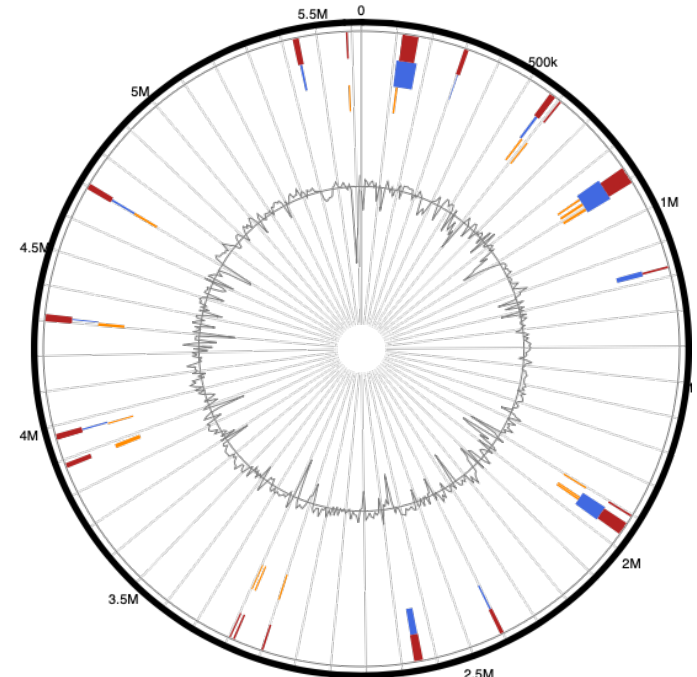
Figure 3. Circular map of the Pseudomonas putida TT321 genome. Genome islands (GIs) are highlighted by color within the circular map for prediction methods. Orange and blue were predicted by SIGI-HMM and IslandPath-DIMOB, respectively. Red regions were predicted GIs by at least one method (integrated GIs). GC contents (%) of the genomic sequence are shown by the black line plot.